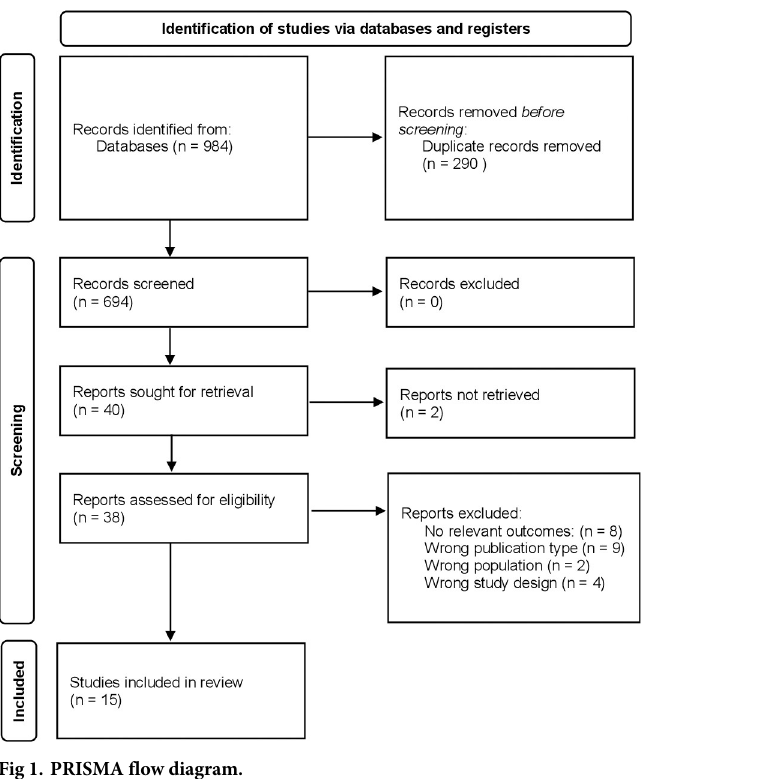
Fig 1. PRISMA flow